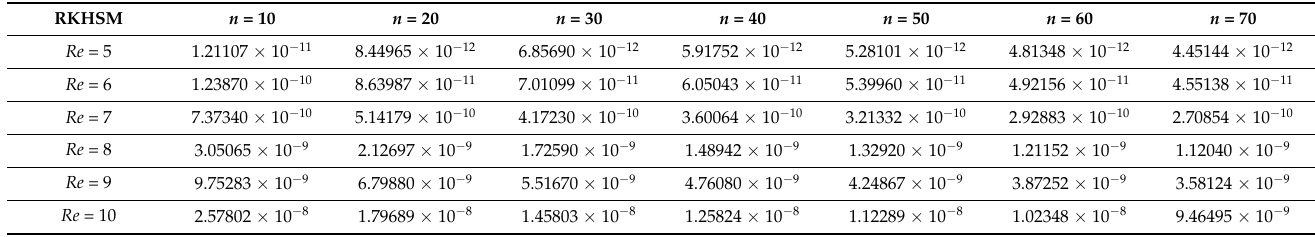
Table 6. Comparison of the residual error (RError) with the RKHSM solutions for the case α = 1 and different values of Re and n .